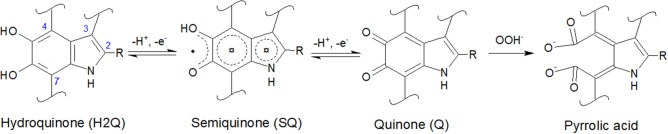
Molecular structures of 5,6-dihydroxyindole (DHI) and 5,6-dihydroxyindole-2-carboxylic acid (DHICA): R is -H in DHI and -COOH in DHICA. DHI and DHICA are building blocks of eumelanin. The redox forms of DHI and DHICA are indicated: hydroquinone (H2Q), semiquinone (SQ), and quinone (Q). OOH− (the deprotonated form of H2O2, present in basic media) can oxidize quinone into pyrrolic acid (Sarna et al., 1986; Korytowski and Sarna, 1990; Smith et al., 2017).